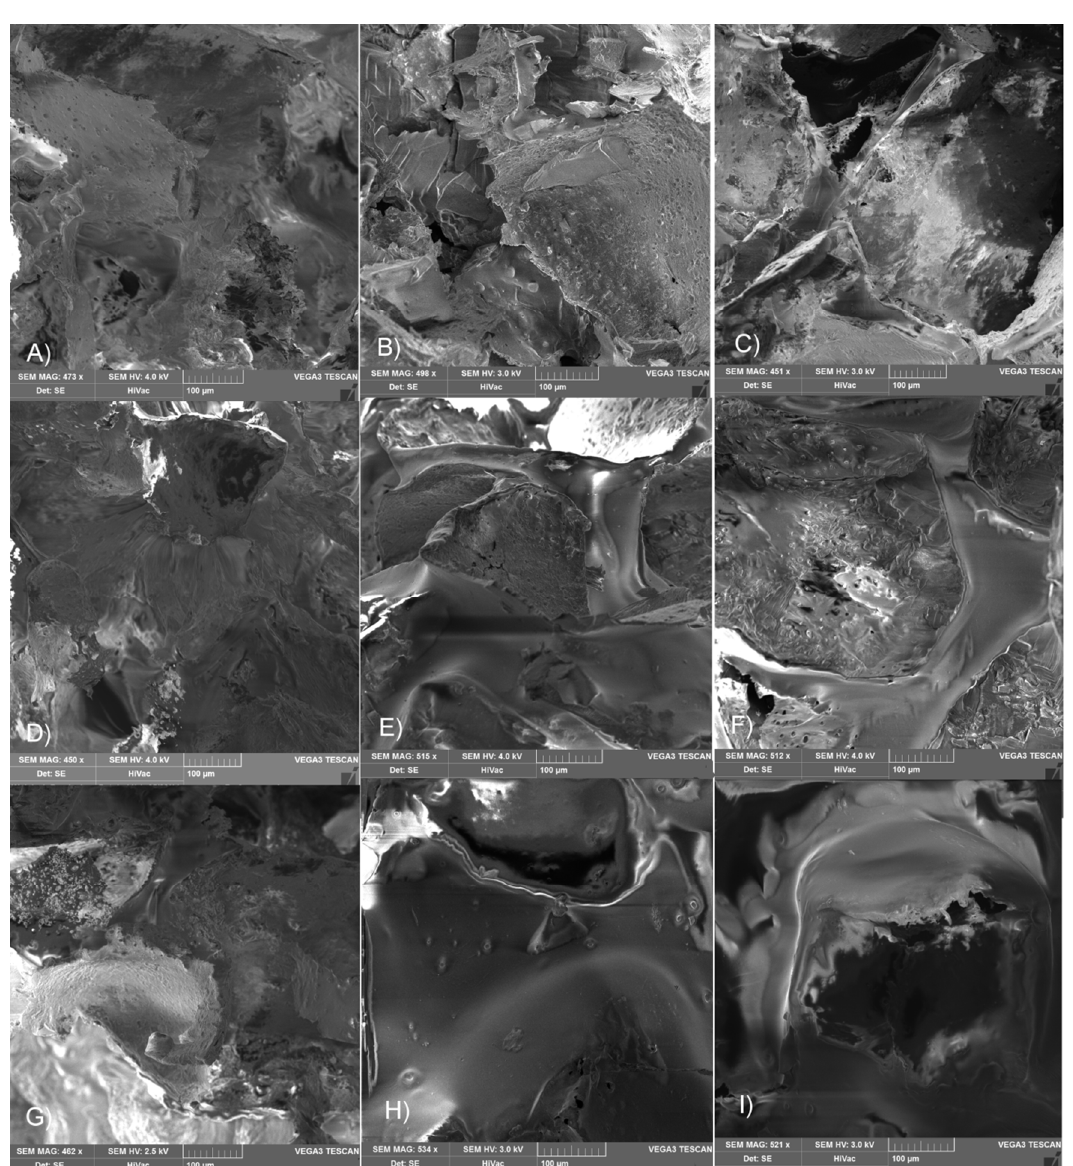
Figure 5. SEM pictures of scaffolds pore surface after electron beam sterilization made of terpolymer LGT21 C with dose ( A ) 10 kGy; ( B ) 15 kGy; ( C ) 25 kGy; terpolymer LGT40 C with dose ( D ) 10 kGy; ( E ) 15 kGy; ( F ) 25 kGy and terpolymer LGC C with dose ( G ) 10 kGy; ( H ) 15 kGy; and ( I ) 25 kGy.